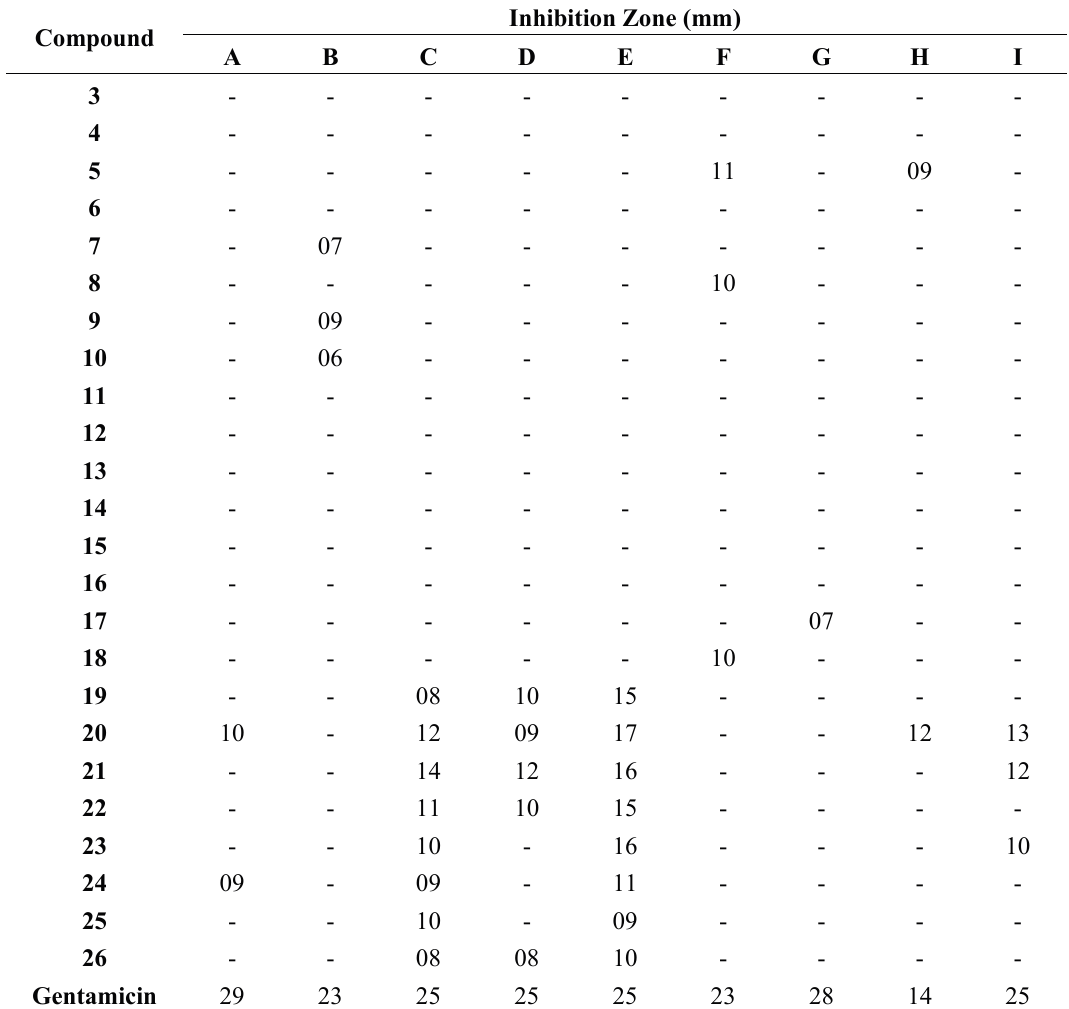
Table 3. Antibacterial activity of compounds 3 – 26 against Gram-negative bacteria (inhibition zones in mm using the disc diffusion method).